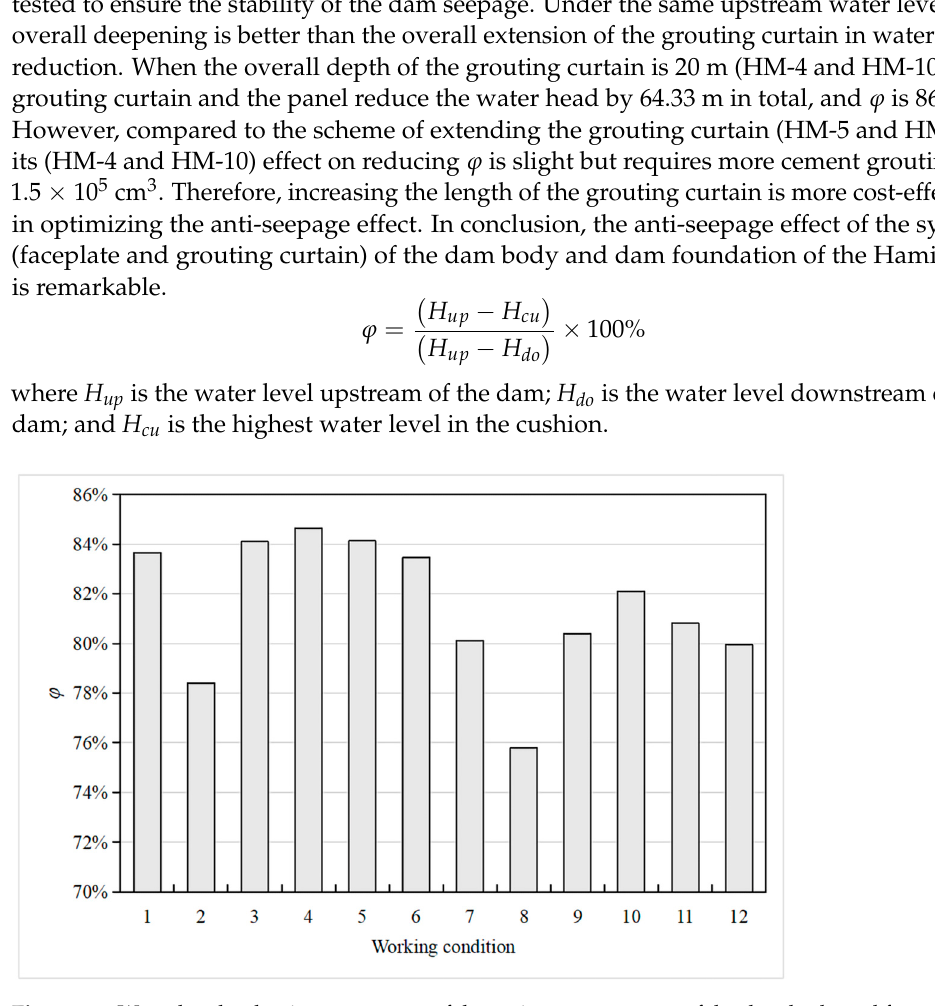
Figure 13. Water head reduction percentage of the anti-seepage system of the dam body and foun-